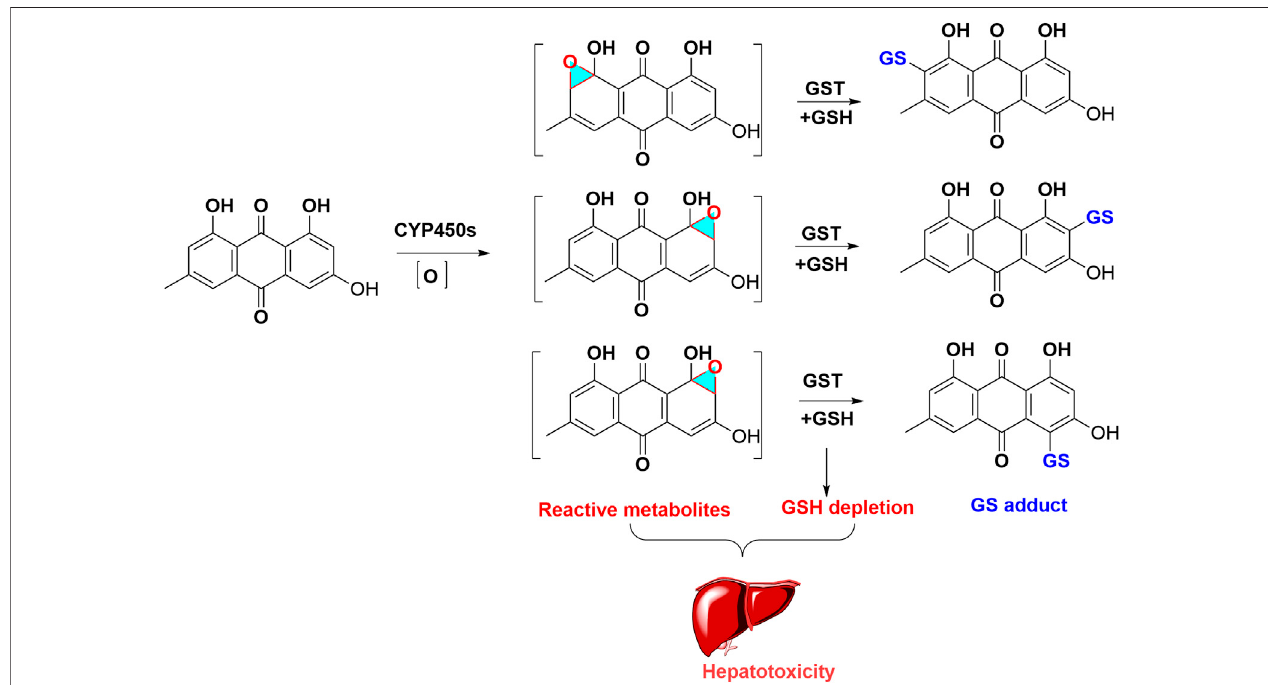
FIGURE 3 | Metabolic activation of emodin induced hepatotoxicity. Emodin formed oxidated intermediates metabolites, these reactive metabolites captured with GSH, and produced GSH adduct, which led to GSH exhaustion.